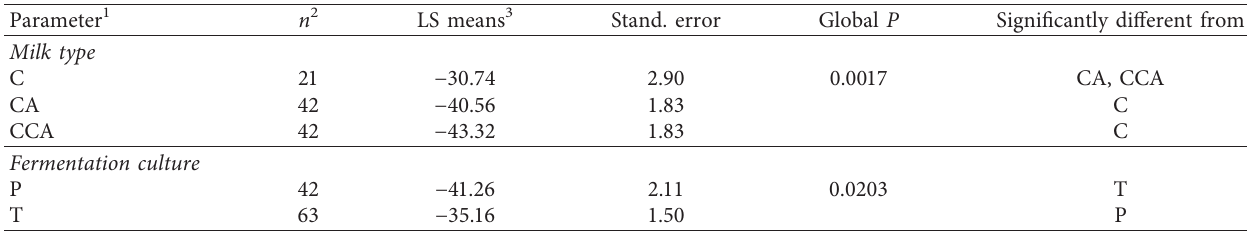
Table 5: Effect of the milk type and starter culture on the improvement of parameters associated with the metabolic syndrome by fermented milk in 105 hypercholesterolemic rats. Parameter 1 n 2 LS means 3 Stand. error Global P Significantly different